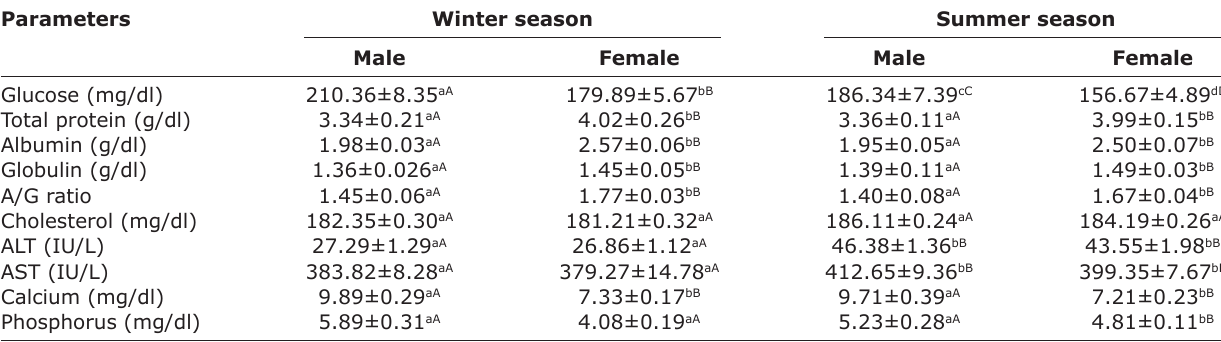
Table-2: Blood biochemical parameters of male and female Vanaraja chickens during summer and winter.